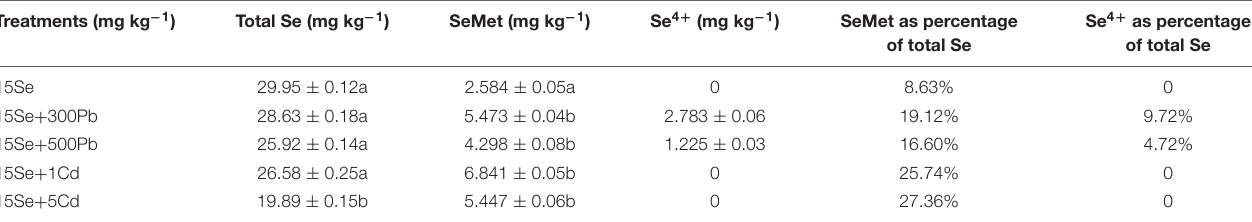
All data show the means+SE of three replicates. Different letters mean significance of difference between the treatments (p ≤